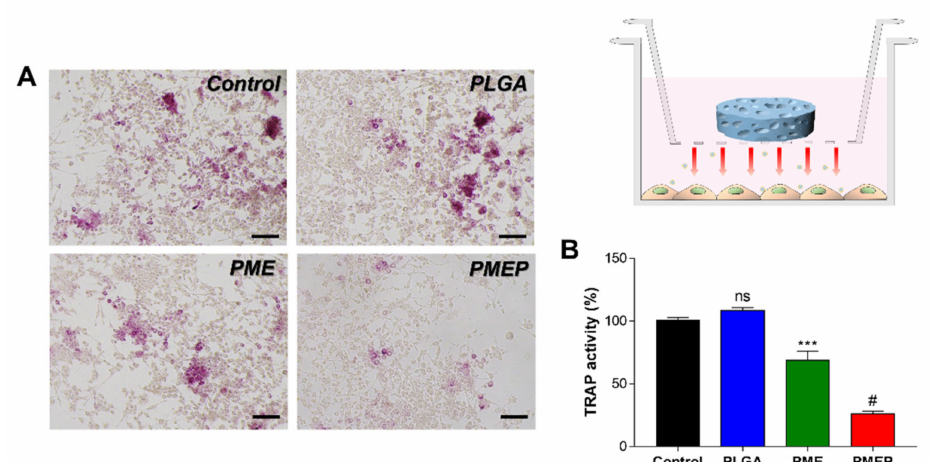
Figure 6. RANKL-induced osteoclastogenesis of RAW264.7 cells for 3 days. Experimental design of osteoclastogenesis using porous scaffold (right above). ( A ) optical images of TRAP+ cells (scale bar = 100 µ m). ( B ) quantification of TRAP activity. The differences were considered significant when ns = not significant ( p ≥ 0.05), *** p < 0.001, and # p < 0.0001 ( n ≥